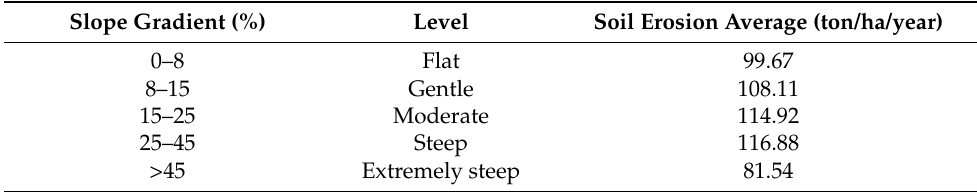
Table 5. Estimated soil erosion average at every level of slope gradient.